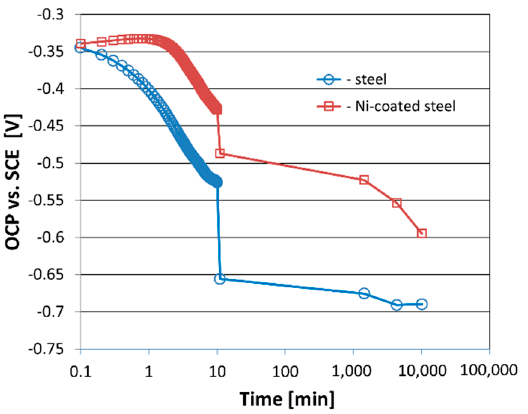
Figure 4. The dependence of the electrode potential versus the time after immersion to 3.5% NaCl solution.